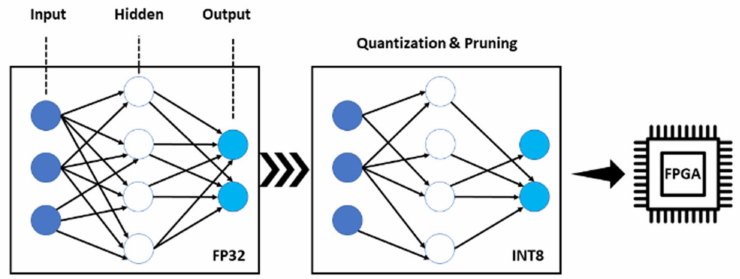
Figure 3. Compression steps prior implementation to